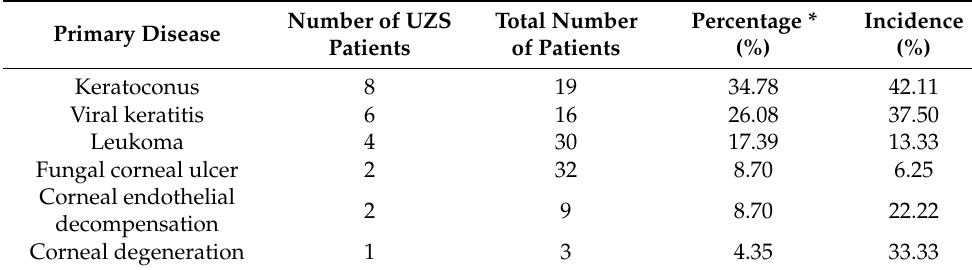
Table 2. Incidence of UZS after PKP in patients with different primary